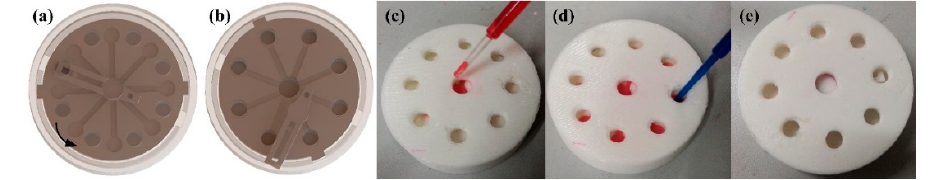
Figure 8. The encapsulation of the microfluidic analytical device: ( a ) Model graph of the device in closed state; ( b ) Model graph of the device in open state; ( c ) Dropping indicating solution in physical model in open state; ( d ) Dropping test solution in physical model in open state; ( e ) Physical model graph of the device in closed state.